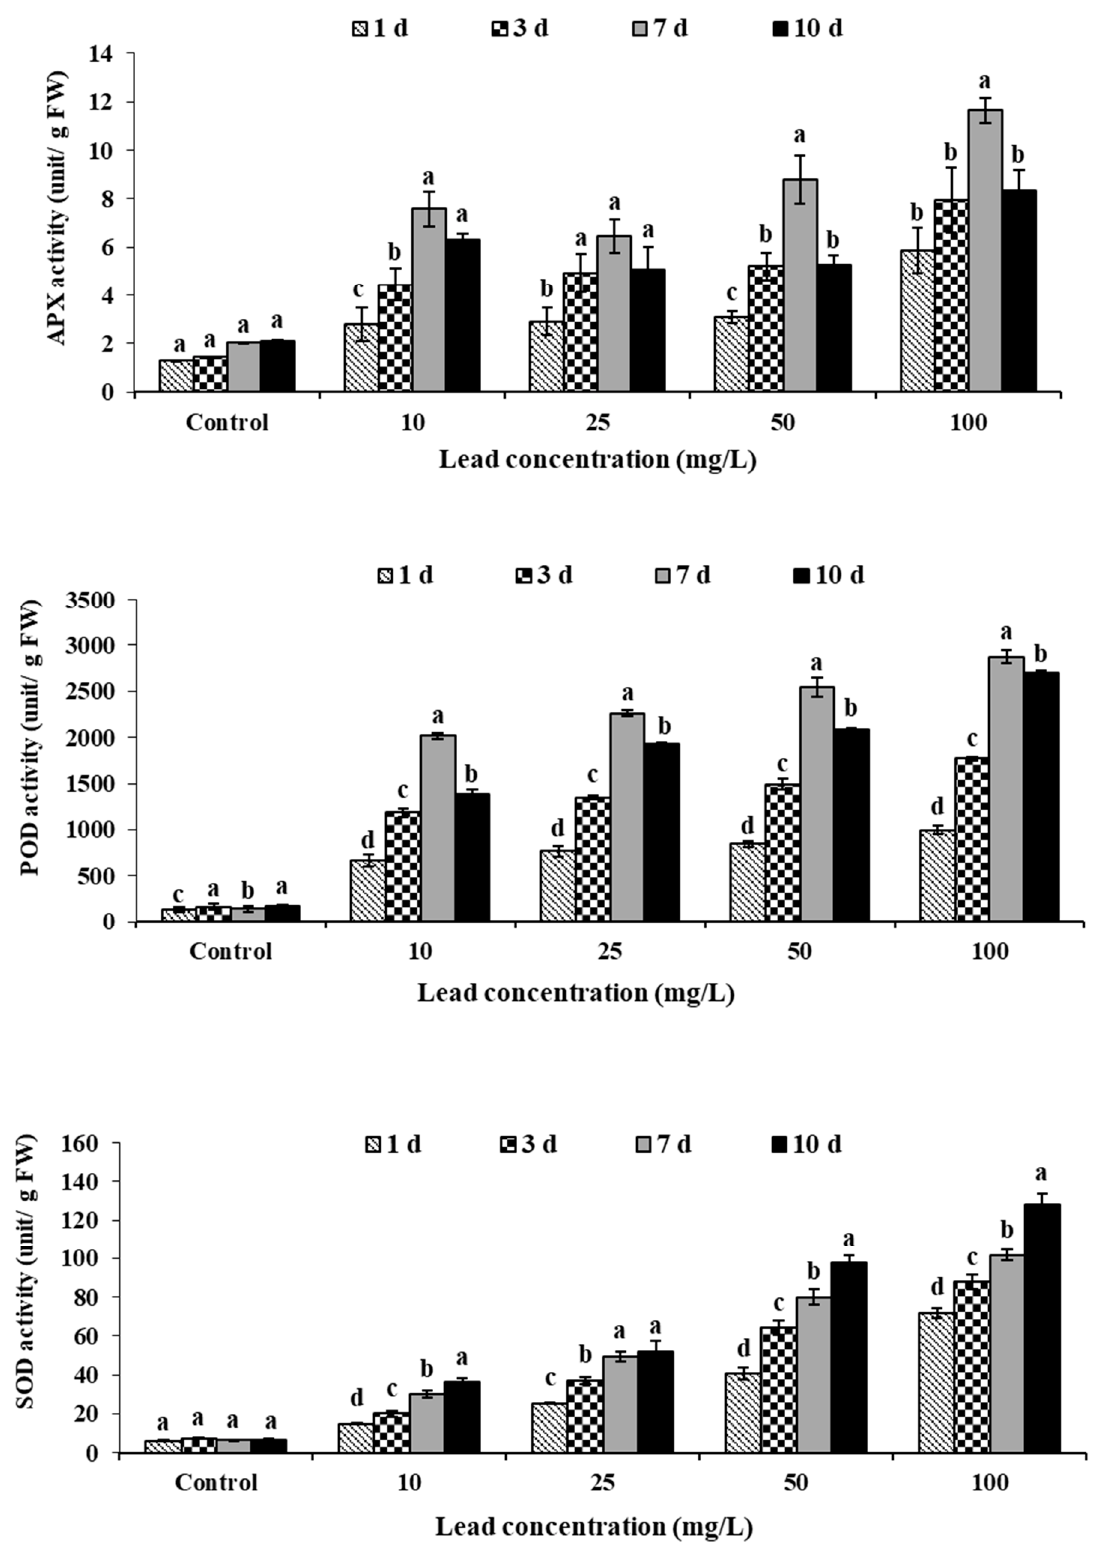
Figure 2. Effects of lead toxicity on APX content, POD, and on SOD activities in Ludwigia stolonifera . Mean values ± SD ( n = 3). ANOVA was significant at p < 0.05. Different letters indicate significantly different values for a particular treatment group (Tukey’s p < 0.05).